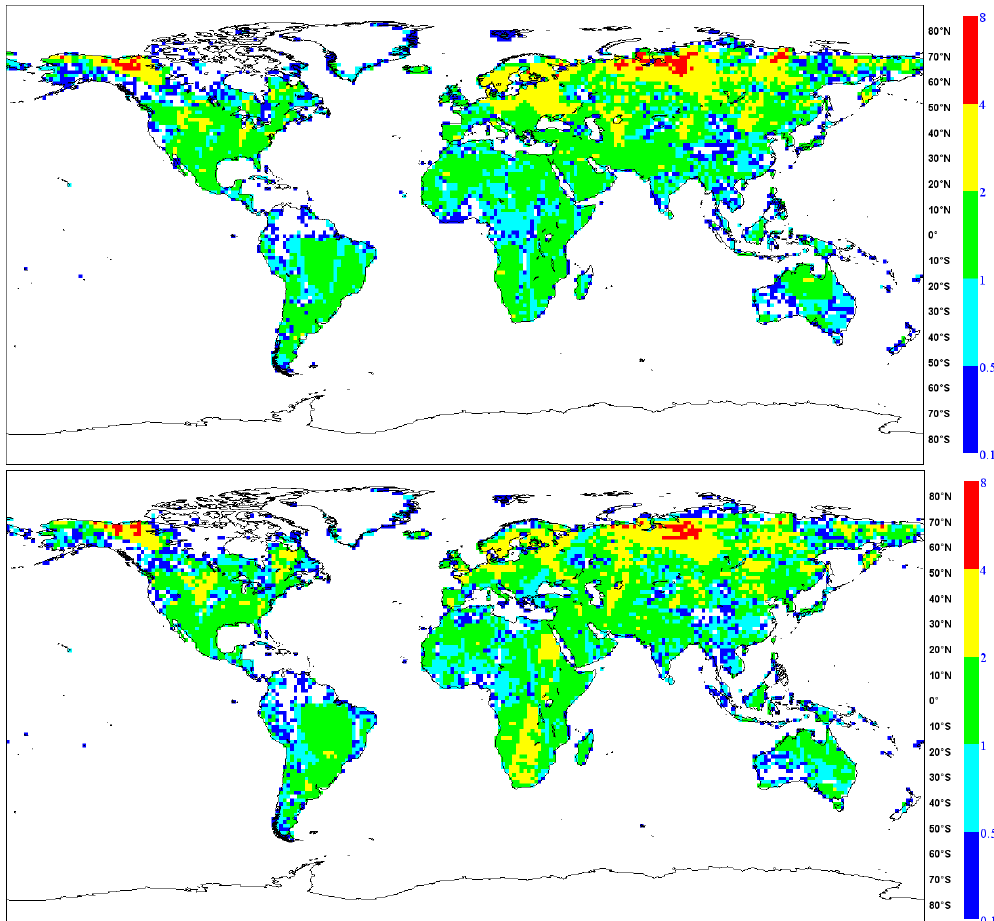
Fig. 2. Effective number of satellite observations of grid cells ( η j ˜ γ j ) by MODIS on Terra (top) and Aqua (bottom) on 4 June 2011, 00:00– 24:00UTC. Equidistant cylindrical projection, 0.5 ◦ resolution. (ECMWF experiment IDs fbl5 and